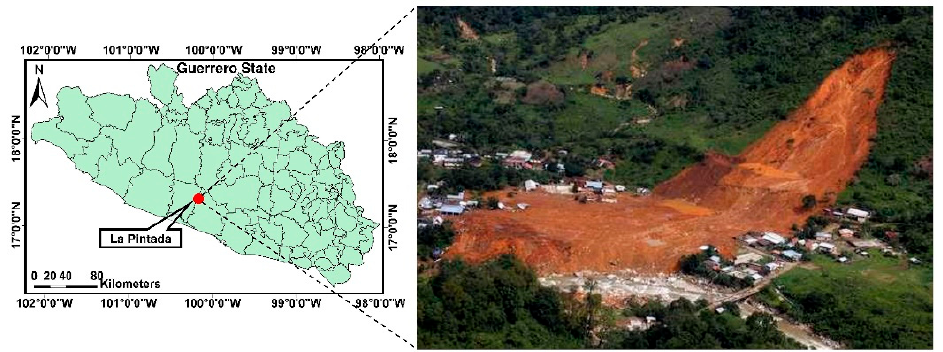
Figure 3. Massive landslide occurred on La Pintada. September 2013 in the study area. Source: https://www.jornada.com.mx/2013/09/24/ciencias/a03a1cie.